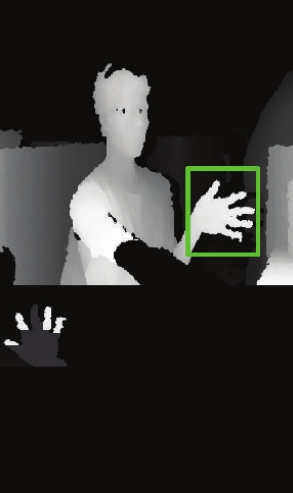
Figure 10: The image at the bottom shows the results after finishing the first round of Step 3.